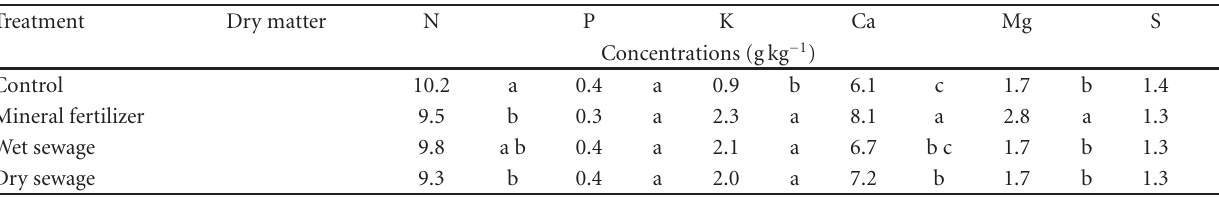
Table 5: Average nutrient concentrations in leaf litter and total amounts of dry matter and nutrients returning to the soil via litterfall from 12 to 36 months after planting.